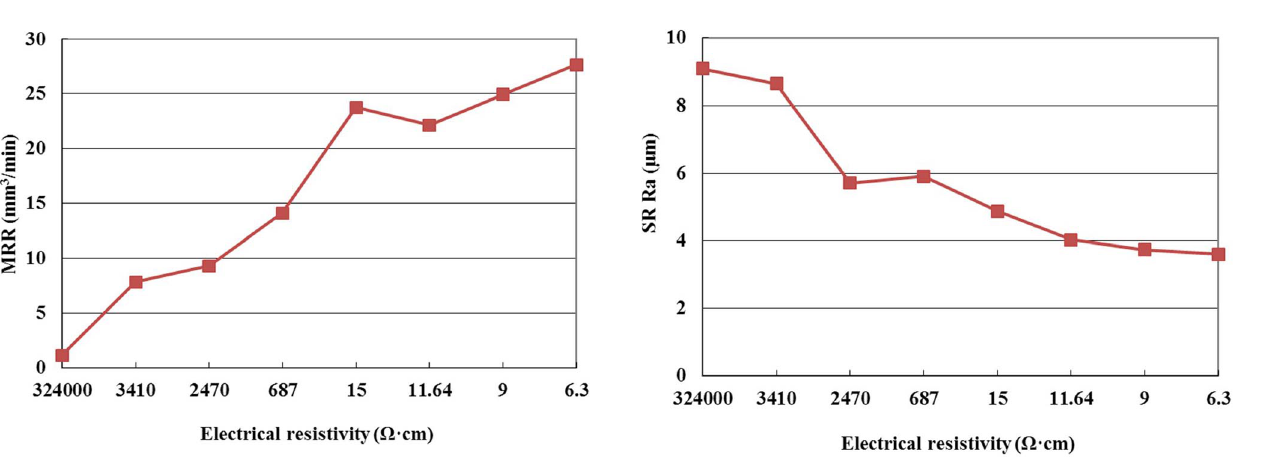
Figure 4. Effect of the electrical resistivity on